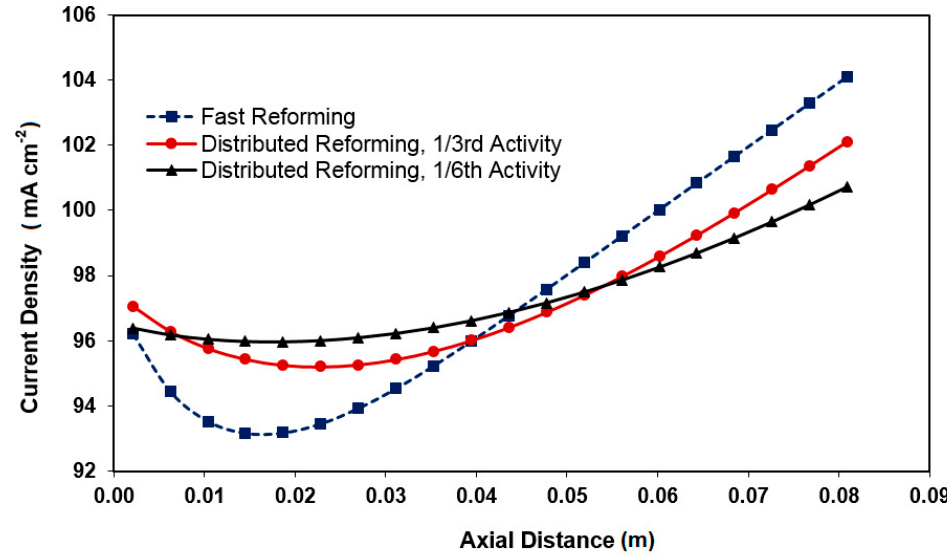
Figure 4. Current density profiles for di ff erent levels of reforming activity and Uf = 65%.